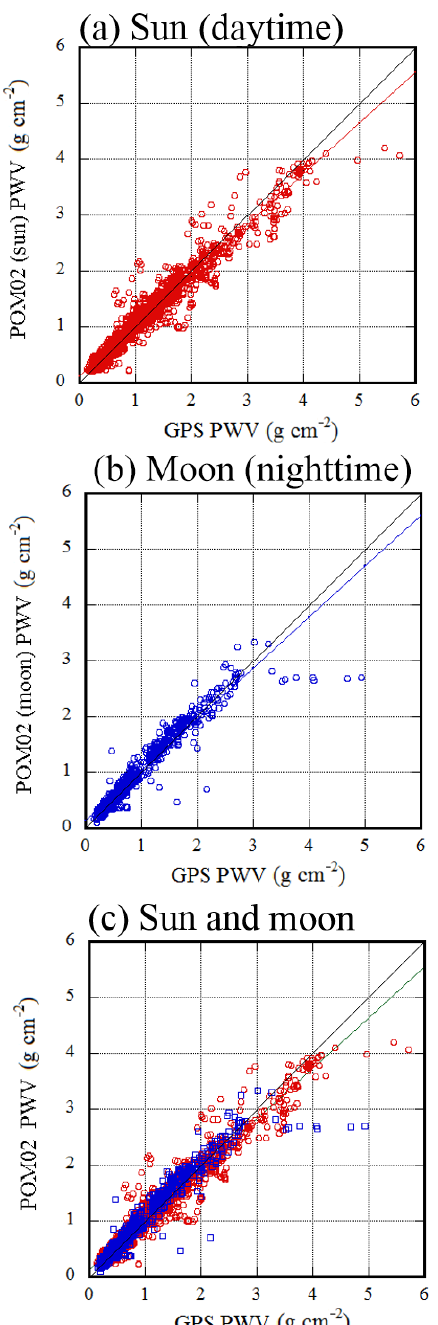
Figure 12. Scatter plot of PWV from GPS and corrected PWV from POM-02: (a) daytime (red), (b) nighttime (blue), and (c) overlap- ping daytime (red) with nighttime (blue).